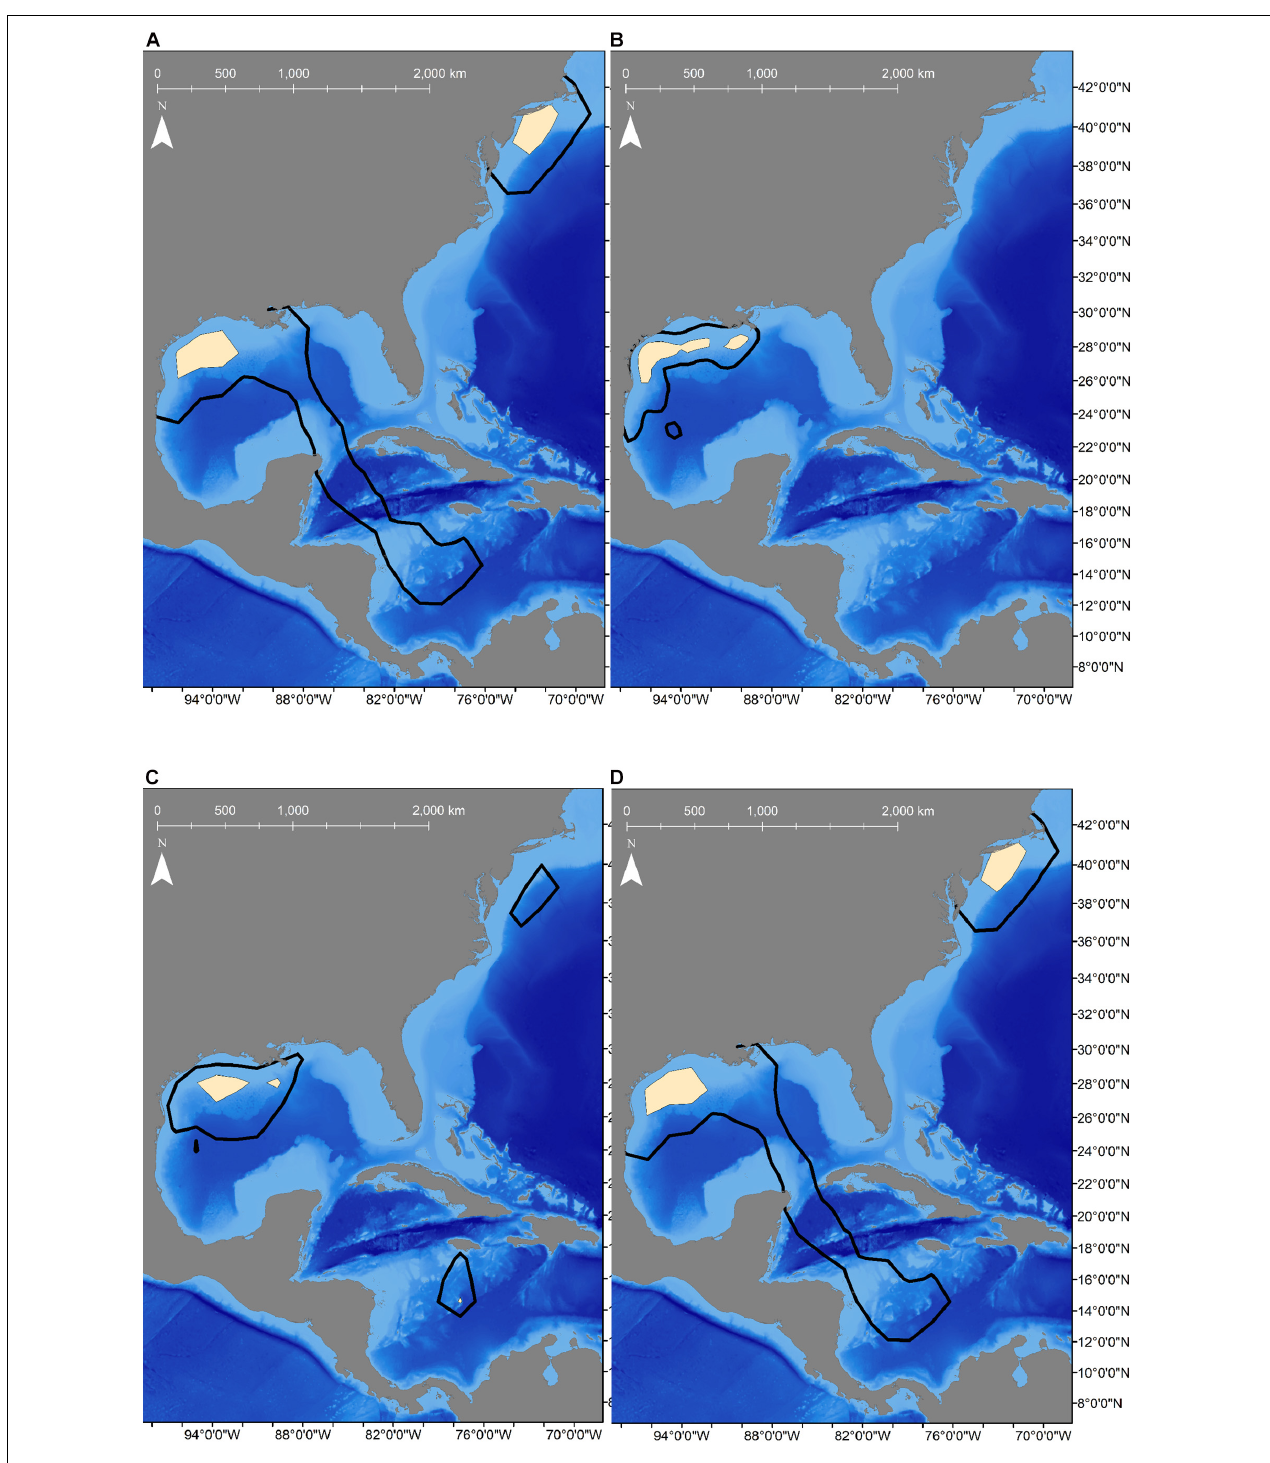
FIGURE 2 | Seasonal population-level Kernel Utilization Distributions (KUD) calculated from satellite-tracked shortfin makos tagged off the Texas coast showing space use changed with the seasons. Black lines represent home range (95% KUD) and tan shaded areas are core area (50% KUD). (A) KUDs calculated for winter ( n = 5 sharks) shows core areas in the northwestern Gulf of Mexico (GOM), but areas off the eastern United States coast was used as well. (B) KUDs for spring ( n = 9 sharks) shows that makos remained in the GOM extensively along the continental shelf and slope. (C) KUDs calculated for summer ( n = 5 sharks) showed more area off the shelf was used in the GOM as well as in the Caribbean Sea and off the northeast coast of the United States. (D) KUDs for fall ( n = 4 sharks) showed two core areas were used in the North Atlantic, including in the northwestern GOM and off the northeastern United States coast.